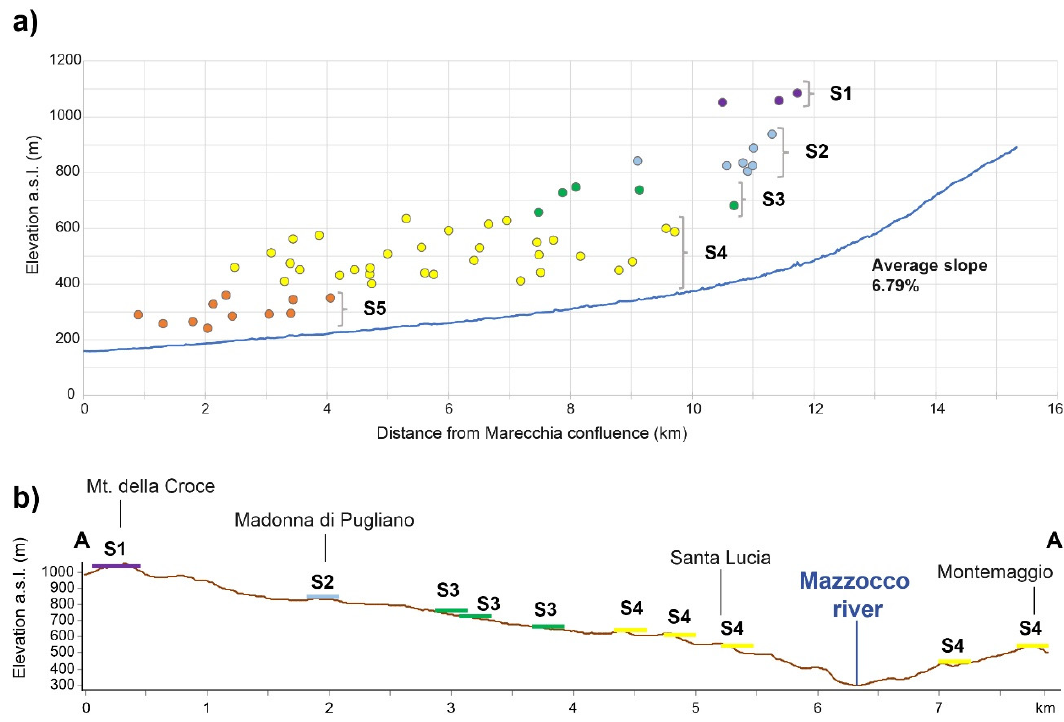
Figure 8. Altimetric distribution of ancient erosional surfaces (Mazzocco river basin); ( a ): distribution along the longitudinal profile; ( b ): distribution along section trace A-A’.